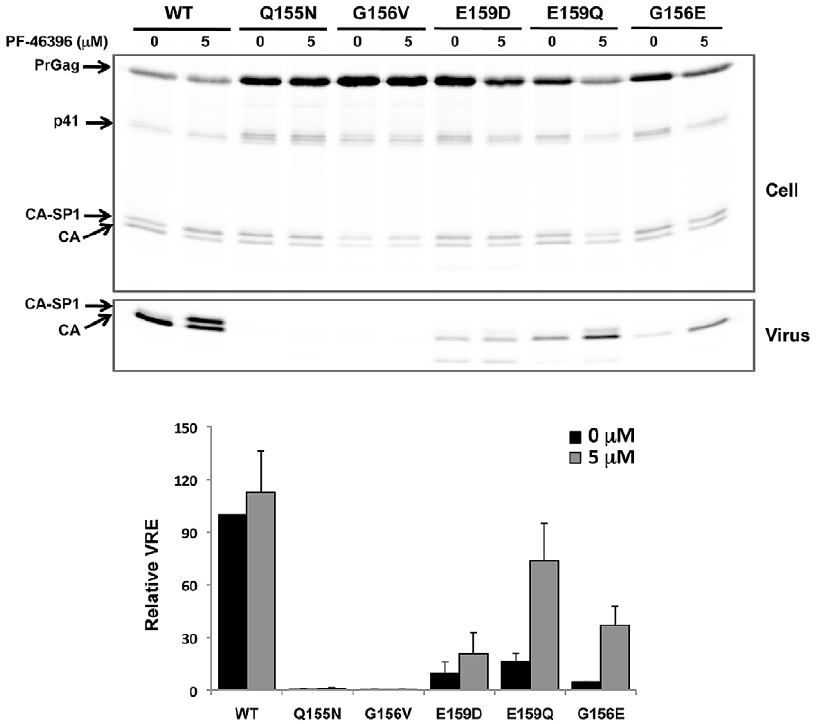
Figure 9. PF-46396 can rescue the assembly/release defect of some but not all MHR mutants. Top panel: Radioimmunoprecipitation analysis of cell- and virion-associated proteins in the absence and presence of 5 m M PF-46396. Positions of Pr55 Gag (PrGag), Pr41 Gag (p41), CA-SP1, and CA are indicated. Lower panel shows phosphorimager-based quantification of relative virus release efficiency (VRE), calculated as described in the Fig. 6 legend. Error bars denote SD; N=3. Note that PF-46396 significantly enhances the release of virus particles for E159Q (and G156E, as shown earlier) but not for Q155N, G156V, or E159D.